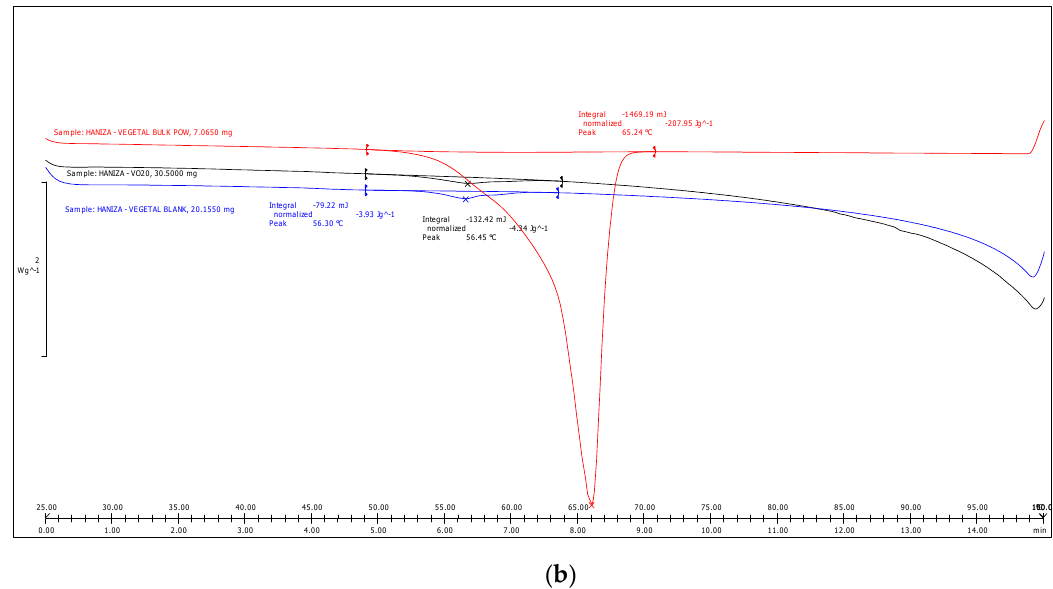
Figure 3. DSC thermograms of: ( a ) acyclovir pure compound and ( b ) Biogapress Vegetal 297 ATO bulk powder (VEGETAL BULK POW), SLNs loaded with 10 mg of acyclovir (VO20) and drug-free SLNs (VEGETAL BLANK).